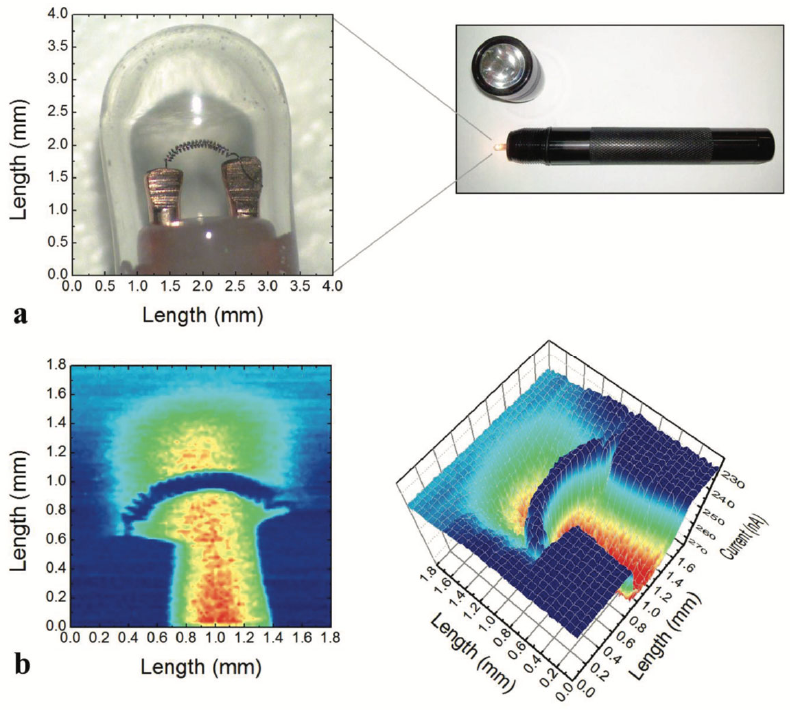
Figure 7. ( a ) A microscope image of the bulb shows the approximately 3 × 3 mm object with a 50 μ m thick spiral filament. ( b ) High resolution HEMT X ‐ ray image of a flashlight bulb. The 2D and 3D images show the plotted X ‐ ray data. Scans were performed with a Pt ‐ gated device with a 500 μ m HEMT channel. The source–drain bias was set to 120 mV and the gate was biased to V G = − 3.5 V. All measurements were performed with 5 keV X ‐ rays at room temperature. Reproduced with permis ‐ sion from [43]. 7. Summary and Conclusions The fabrication of GaN heterostructures with improved quality, at economic scale, is now mature. GaN ‐ based devices are capable of significantly outperforming their silicon ‐ based counterparts. To date, little attention has been paid to GaN ‐ based X ‐ ray detection. However, we believe that the introduction of a 2DEG channel, by adding AlGaN/GaN het ‐ erointerfaces into the GaN thin film, will open another chapter in GaNification [10], as the tremendous sensitivity of GaN HEMT sensors will reach a new level of hardware innova ‐ tion, reducing the effective dose used today in routine X ‐ ray and CT scans. Device dimen ‐ sions, i.e., pixel size, can be reduced by orders of magnitude using modern standard micro ‐ fabrication techniques. Thus, there should be no practical constraints on the production of large ‐ area X ‐ ray sensors based on pixel arrays. High ‐ resolution imaging using the shown integrated GaN HEMT pixel sensors should be possible based on our proof ‐ of ‐ principle measurements [44,45]. The material properties of GaN heterostructures such as robust ‐ ness, light weight, and features such as room temperature operation without cooling, ex ‐ cellent signal ‐ to ‐ noise ratio, and the 2DEG ‐ based tuneable intrinsic sensitivity, altogether form the basis for enabling a paradigm shift in X ‐ ray detector technology. Author Contributions: Conceptualization, S.T., A.W. and W.N.; methodology, A.H., M.K., S.E. and F.P.; writing—original draft preparation, S.T. and W.N.; writing—review and editing, A.W. and W.N.; All authors have read and agreed to the published version of the manuscript.